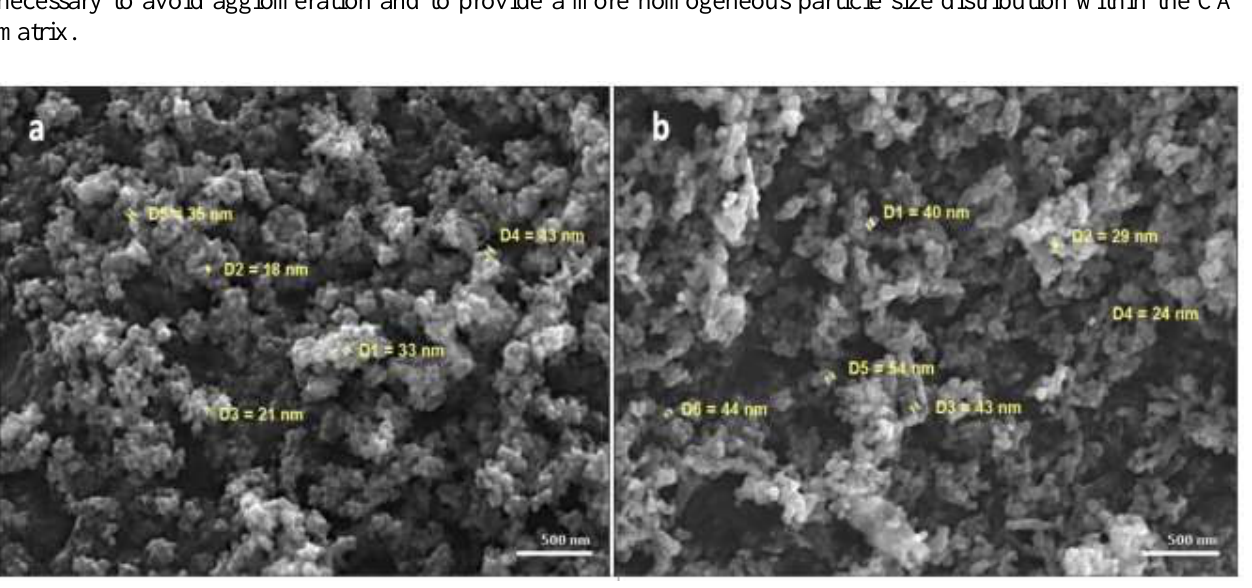
Figure 2: SEM images of (a) TiO 2 nanoparticle , (b) ZnO